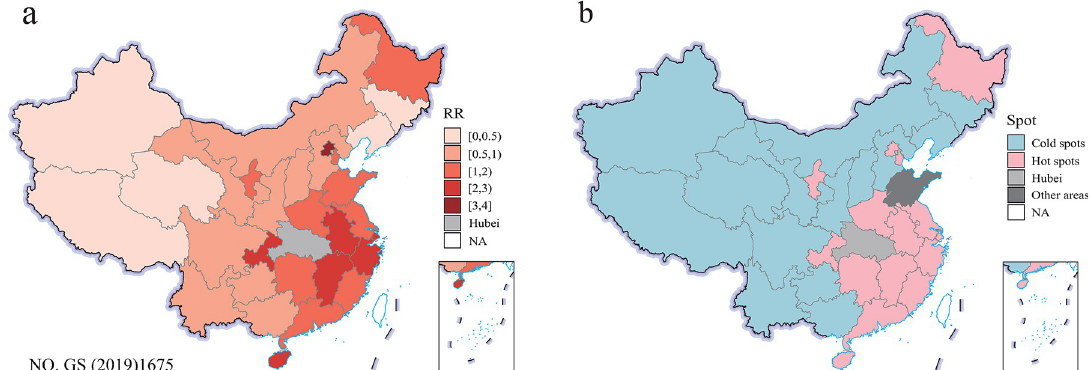
Fig 2. Estimated RR values (a) and hot-cold spots (b) of COVID-19 by Bayesian spatial model without covariables in the 30 provinces in mainland China (outside of Hubei), from 16 January 2020 to 31 March 2020. The original map image was obtained from the China Ministry of Natural